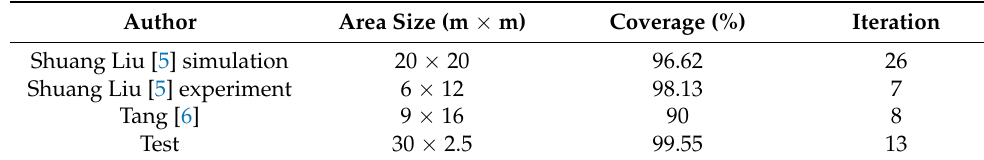
Table 1. Comparison of results.